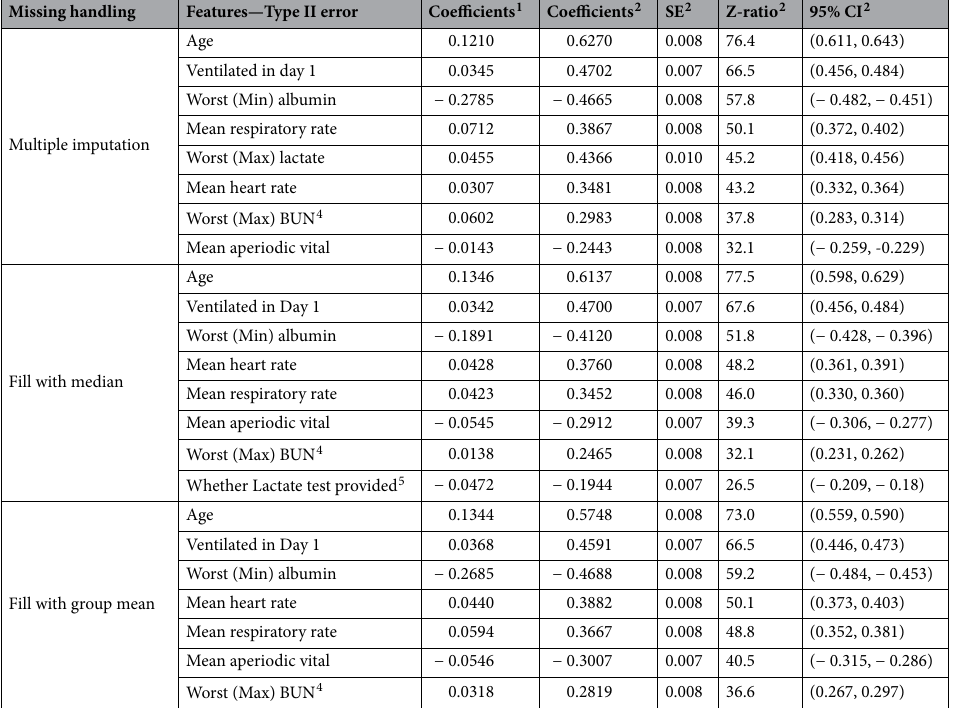
Table 6. Features selected for Type II error when using cutoff 0.33, with ARC removed. 1 Coefficients calculated from fitting the Lasso feature selection model. 2 Coefficients, SE, Z-ratios, and the 95% CIs calculated by ordinary logistic regression using the selected features from Lasso; Features sorted by Z-ratios, where Z-ratio = | Coefficient / SE | . 4 BUN: Blood Urea Nitrogen test. 5 Whether a lactate test was provided within the first 24